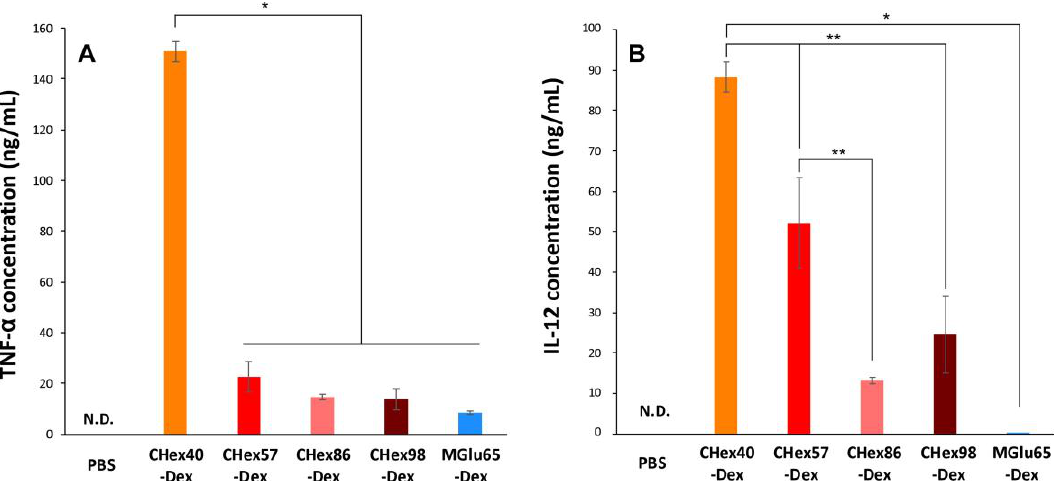
Figure 9. TNF-α ( A ) and IL-12 ( B ) production from DC2.4 cells treated with liposomes modified with dextran derivatives (1 mg/mL) for 24 h. ** p < 0.05. * p <